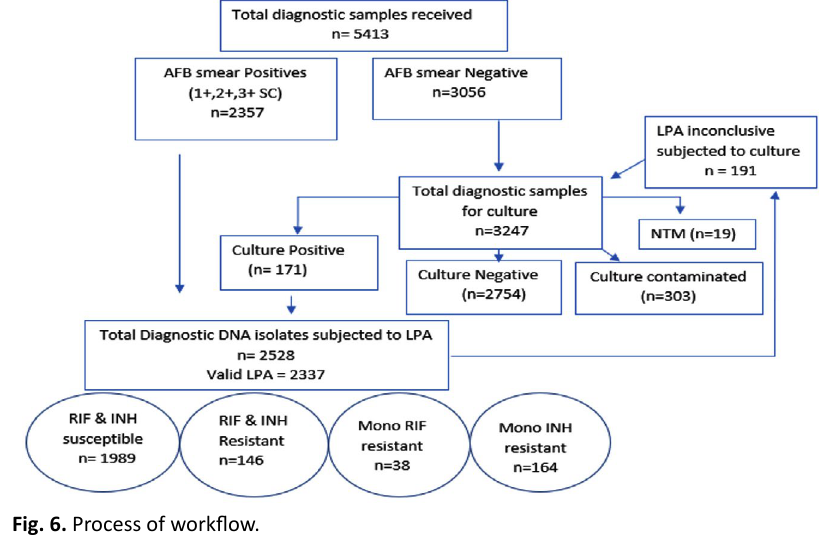
Fig. 6. Process of workflow.